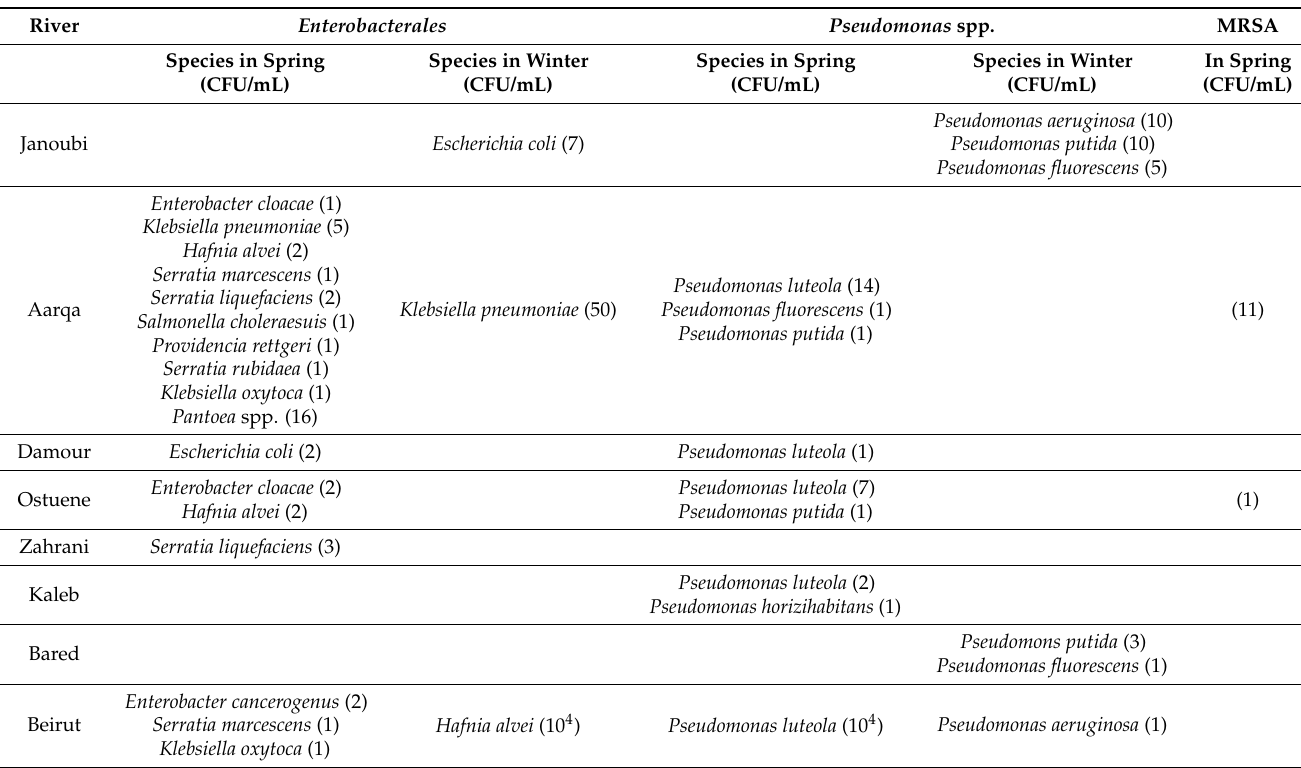
Table 1. Gram-negative bacterial species and Gram-positive MRSA isolated in the rivers’